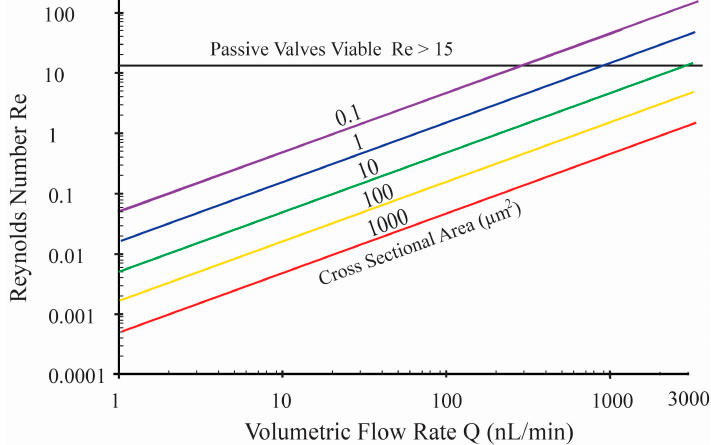
Figure 1. Family of curves showing Reynolds number vs. flow rate in rectangular channels for various flow channel cross sectional sizes. Passive valves are ineffective in the laminar flow regime requiring active valves for robust flow rectification.